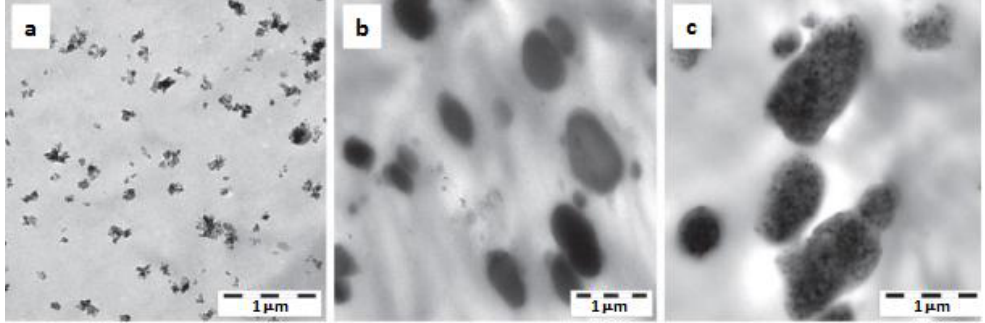
Figure 7. Dispersion of ( a ) boehmite alumina (BA); ( b polyurethane (PU)); ( c ) BA + PU in a polyoxymethylene (POM) based system based on transmission electron microscopy